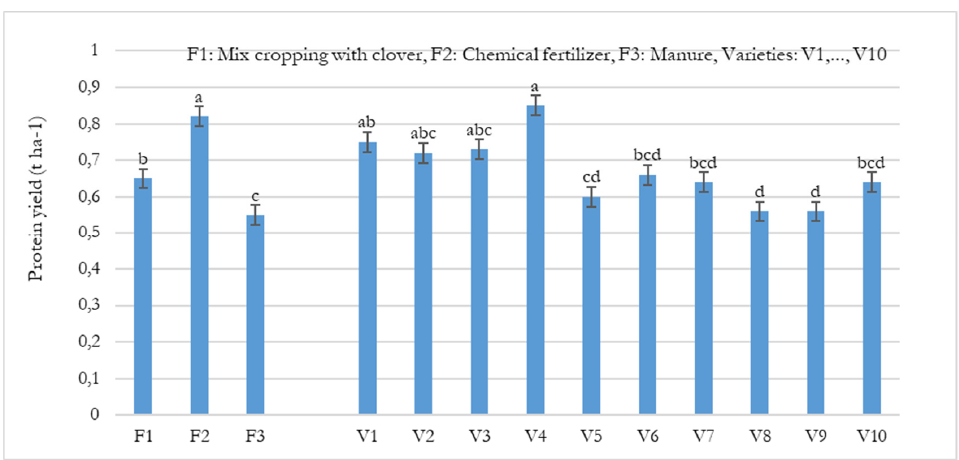
Figure 2. Effect of fertilization and variety on wheat protein yield Means followed by the same letter shows no significant differences among treatments at 0.05 level by LSD V1= ‘Mazar-99’, V2= ‘Baghlan-09’, V3= ‘Chont-1’, V4= ‘Kabul-13’, V5= ‘Gul-96’, V6= ‘Mugawim’, V7= ‘Shoshom- b08’, V8= ‘Drokhshan-09’, V9= ‘Lalmi-4’ and V10=